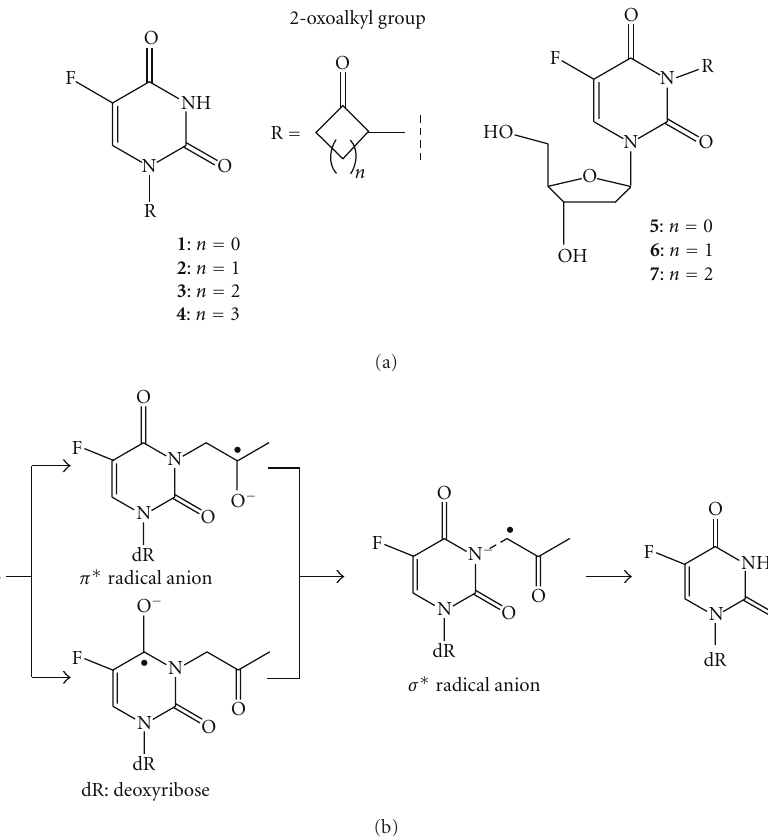
Figure 2: (a) Radiation-activated prodrugs of 5-flurouracil ( 1–4 ) and 2 (cid:3) -deoxy-5-fluorouridine ( 5–7 ) possessing 2-oxoalkyl groups. (b) Plausible mechanism for reductive release of 2-oxoalkyl group.